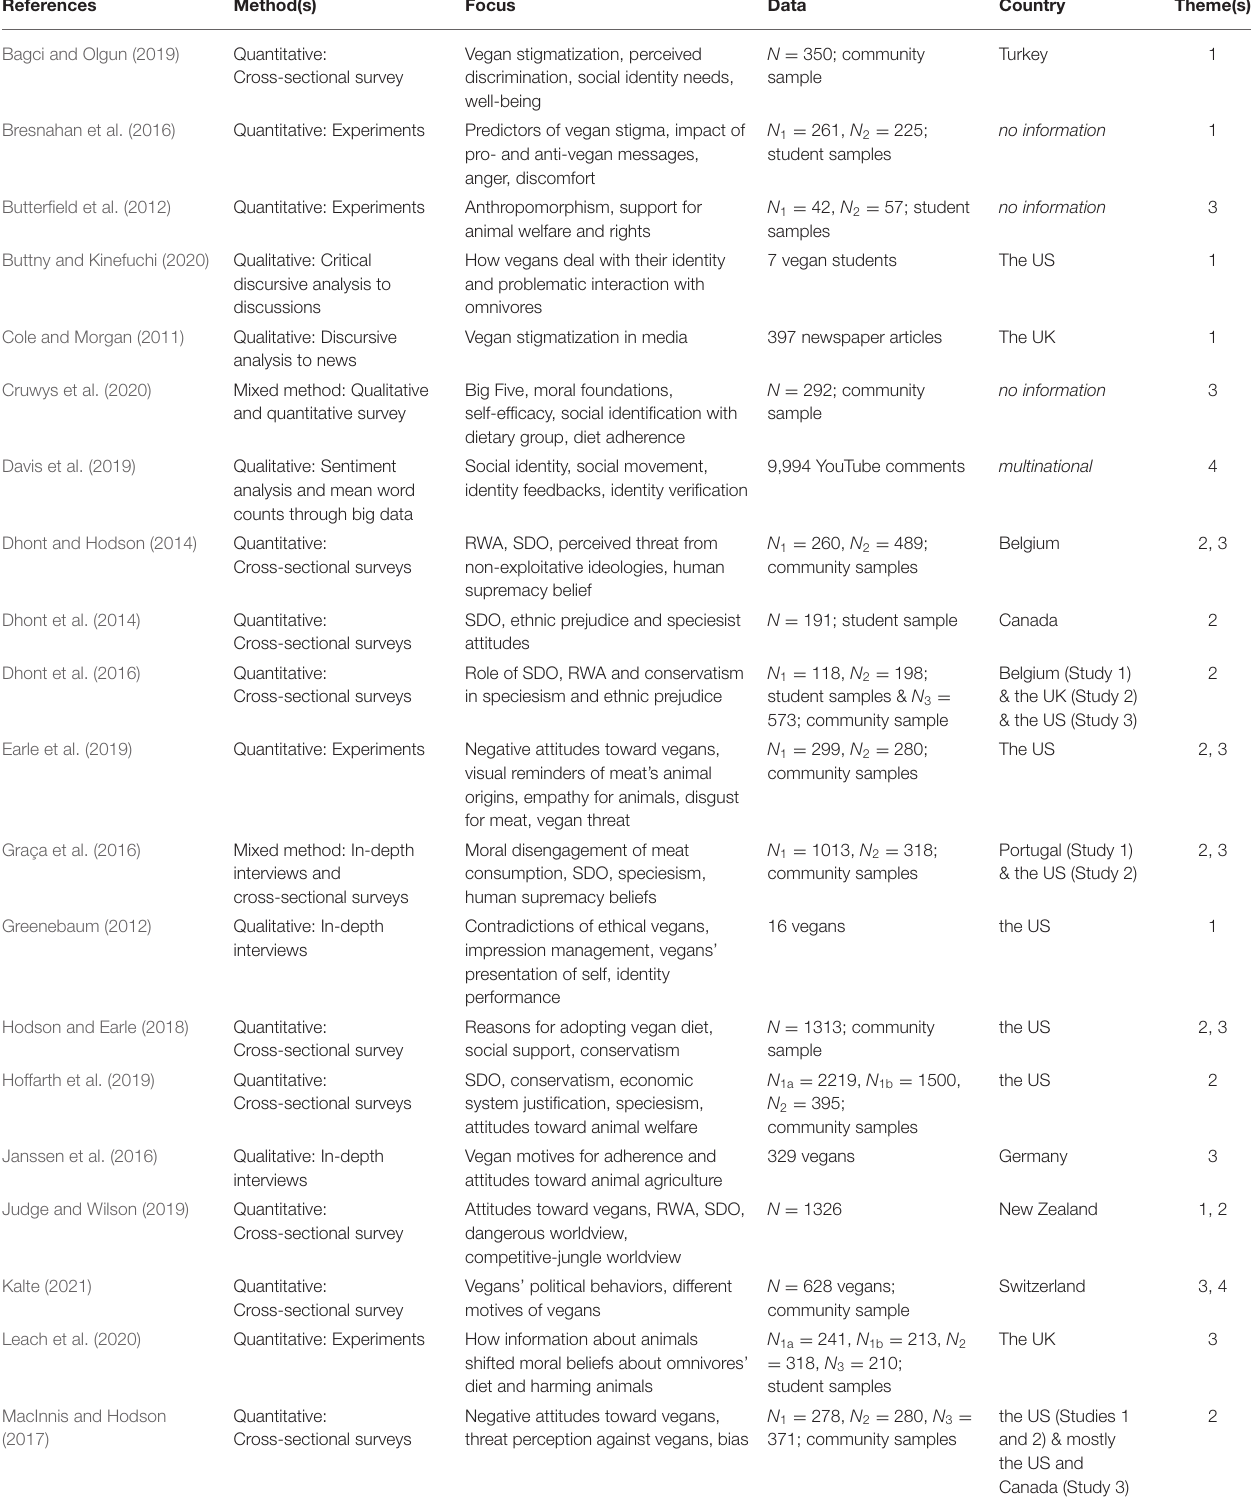
TABLE 1 | List of reviewed studies and their